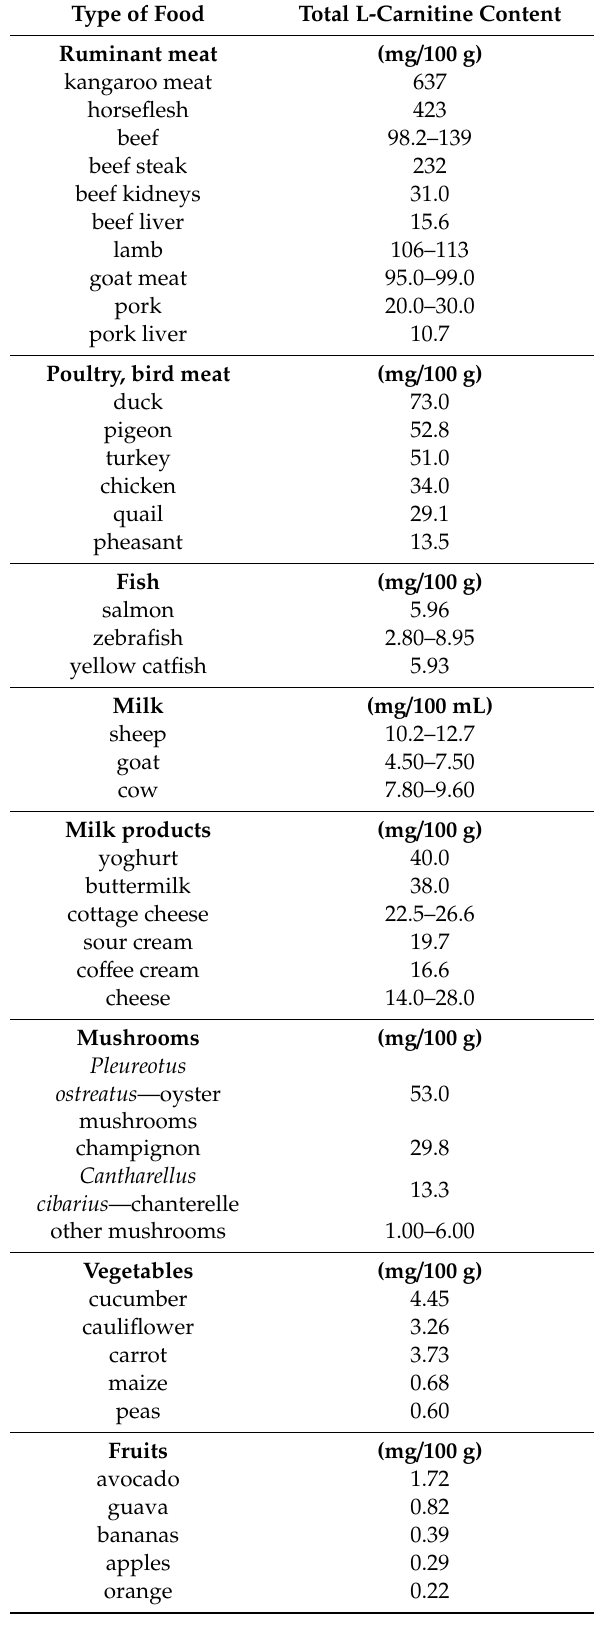
Table 2. The amount of L-carnitine in product groups [61,88]